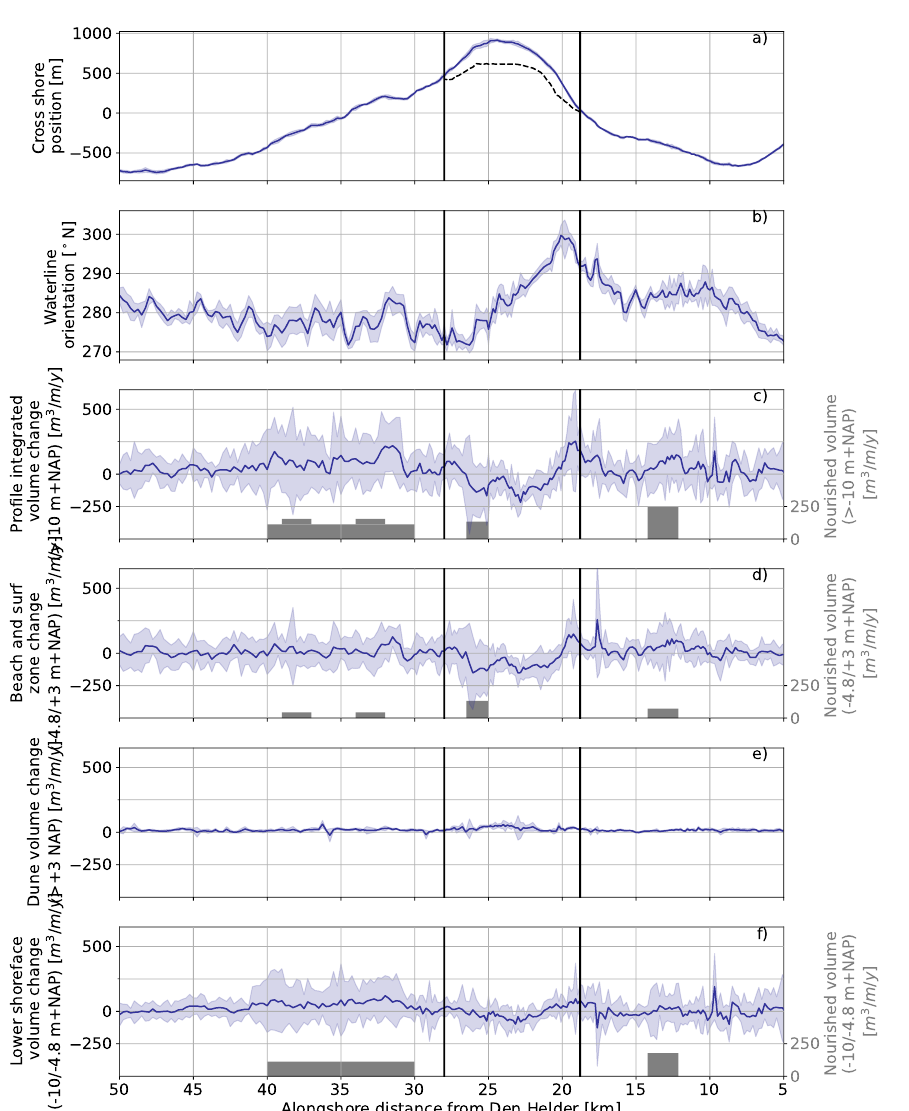
Figure 9. Volumetric evolution of North-Holland coast with the nourished section in between the black vertical lines (JARKUS dataset only). ( a ) Cross-shore position of the waterline (relative to the waterline position at km 0.2), the position the prenourishment waterline in black stripes. ( b ) Orientation of the waterline. ( c ) Yearly profile-integrated volume change (> − 10 m + NAP). ( d ) Yearly volume change in the beach and surfzone ( − 4.8 m + NAP and 3 m + NAP). ( e ) Yearly dune volume change (above 3 m + NAP). ( f ) Yearly volume change on the shoreface ( − 10 m + NAP to − 4.8 m + NAP). Blue shadings gives the ± σ interval and solid blue lines the average over the